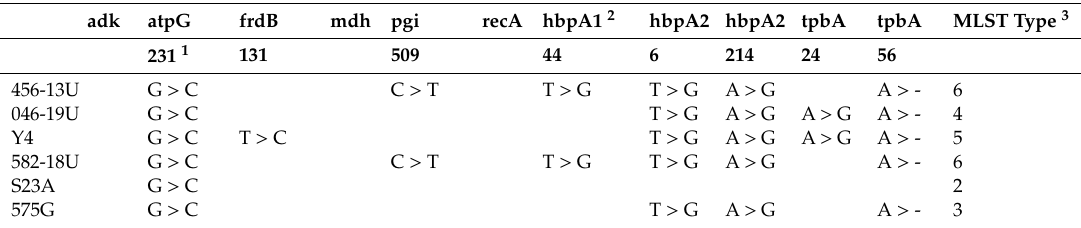
Table 2. Polymorphic sites for six A. actinomycetemcomitans strains with various leukotoxin promoter types, as compared to the JP2 strain HK1651, characterized by a 530-bp deletion. Nucleotides in genes/gene fragments sequenced.